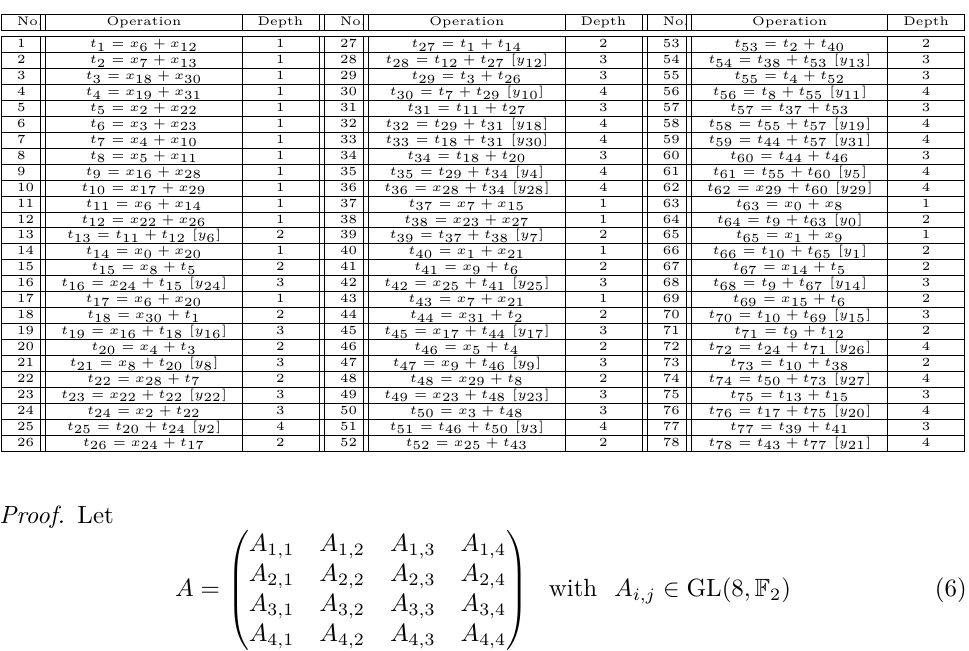
Table 5: An implementation of H , corresponding to parameter (0 , 0 , 4 , 0 , 2 , 2), with 78 XOR gates and depth 4, where ( x 0 , · · · , x 31 ) are input signals, ( y 0 , · · · , y 31 ) are output signals, and t i ’s are intermediate